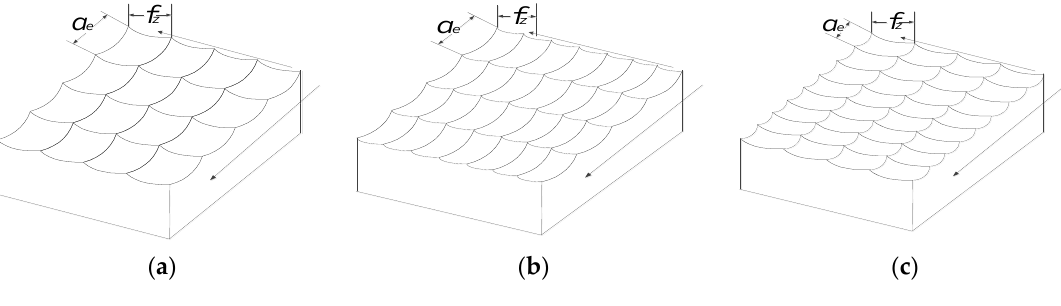
Figure 10. Arrangement of micro units.